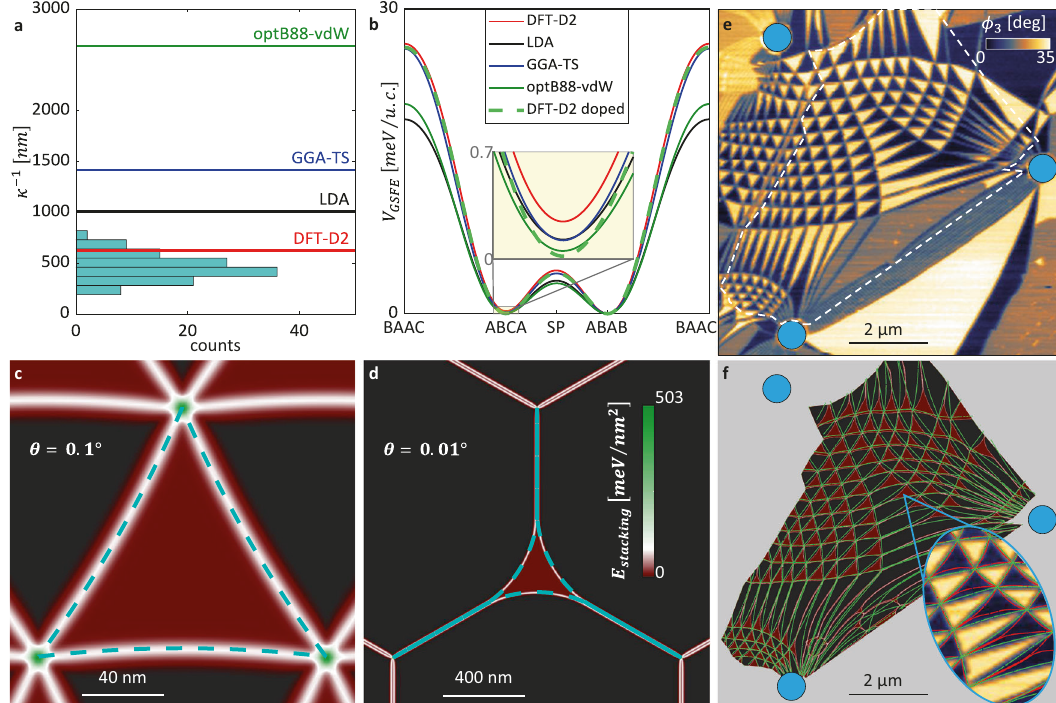
Fig. 3 Moiré super-lattice study of rhombohedral domains in twisted double bilayer graphene (TDBG). a Curvature histogram across all measured domains near charge neutrality point (see discussion in Supplementary Information S7), showing a clear cluster at 440 ± 120 nm. Calculated curvatures of 4 DFT approaches (of b ) are illustrated over the histogram (colored horizontal lines). b GSFE of TDBG based on four different approaches (solid lines, see “ Methods ” ). The dashed light-green line is the GSFE for DFT-D2 approach at a doping level of 8 × 10 12 cm − 2 . Inset: enlarged view highlighting small difference between ABCA and ABAB con fi gurations ( V GSFE ( ABAB ) = 0 identically). c , d Mechanical relaxation solutions (false-color: stacking energy density) and “ soap-bubble ” model domain shape (dashed turquoise) for two representative twist angles ( c : θ = 0.1°, d : θ = 0.01°) for DFT-D2. e Mid-IR (940 cm − 1 ) near fi eld phase imaging of a defect-induced doped TDBG (see Supplementary Information S7). 3 holes punctured one of the bilayers (blue circles — see “ Methods ” ) and induce a non-trivial external strain map. Mid-IR imaging resolves ABCA (dark) and ABAB (bright) phases and double-domain wall (DDW) formations (for instance, the multiple-DDW formation connecting bottom holes). f Comparing relaxation calculations solutions of un-doped vs. 8×10 12 cm 2 doped DFT-D2 approach GSFE, simulating the experimental case (marked by dashed shape in e ), False-color represents stacking energy density of un-doped case, overlaid (green dots) with tracked domain walls in the doped case. Inset: highlighting differences between model by overlaying domain wall formation of doped (red) and un-doped (green) cases over strained region in the experimental map. The color-map is shared for ( c – e